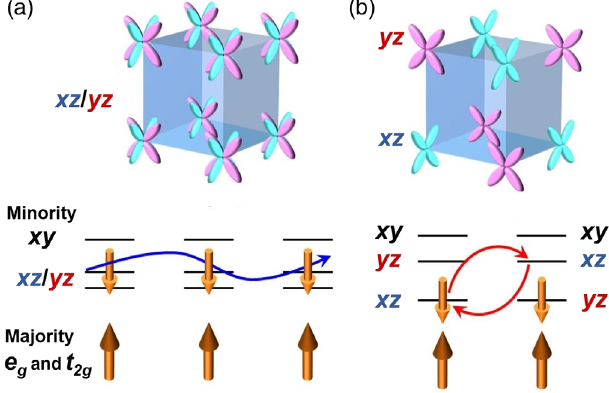
FIG. 5. Schematics of orbital structure and its correlation with ferromagnetic ground state. (a) Unstrained (or low strained) SrCoO 3 with twofold degenerate xz and yz bands, and (b) highly strained SrCoO 3 with alternating xz=yz orbital ordering. In (a), mobile minority electrons in the xz=yz band mediate double- exchange FM interaction. In (b), on the other hand, the virtual excitation of minority electrons from occupied xz ( yz ) orbital to neighboring unoccupied xz ( yz ) orbital induces Kugel-Khomskii- type FM superexchange